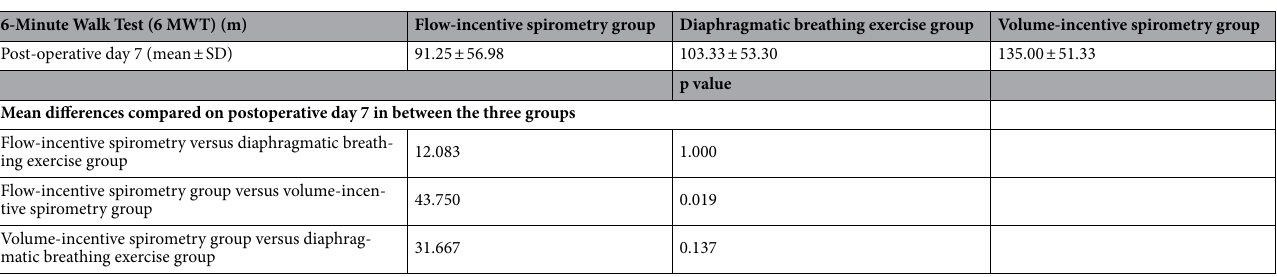
Table 3. Comparison of 6-Minute Walk Test, on post-operative day 7, between three intervention groups. p < 0.001 highly significant.